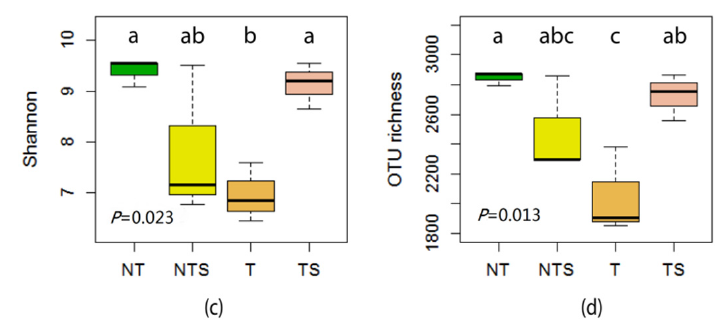
Figure 1. Alpha diversity of the soil bacterial community according to the Chao1 ( a ), Simpson ( b ), Shannon ( c ), and OTU richness ( d ) indexes as affected by tillage and crop residue management treatments. NT, no-tillage with all crop residue removed at harvest; NTS, no-tillage with crop residue chopped and spread evenly on the soil surface; T, conventional tillage with all crop residue removed at harvest; TS, conventional tillage with all crop residue chopped, spread evenly on the soil surface, and incorporated into the soil via plowing. Boxplots with different letters above the boxes denote means that are significantly different ( p < 0.05).